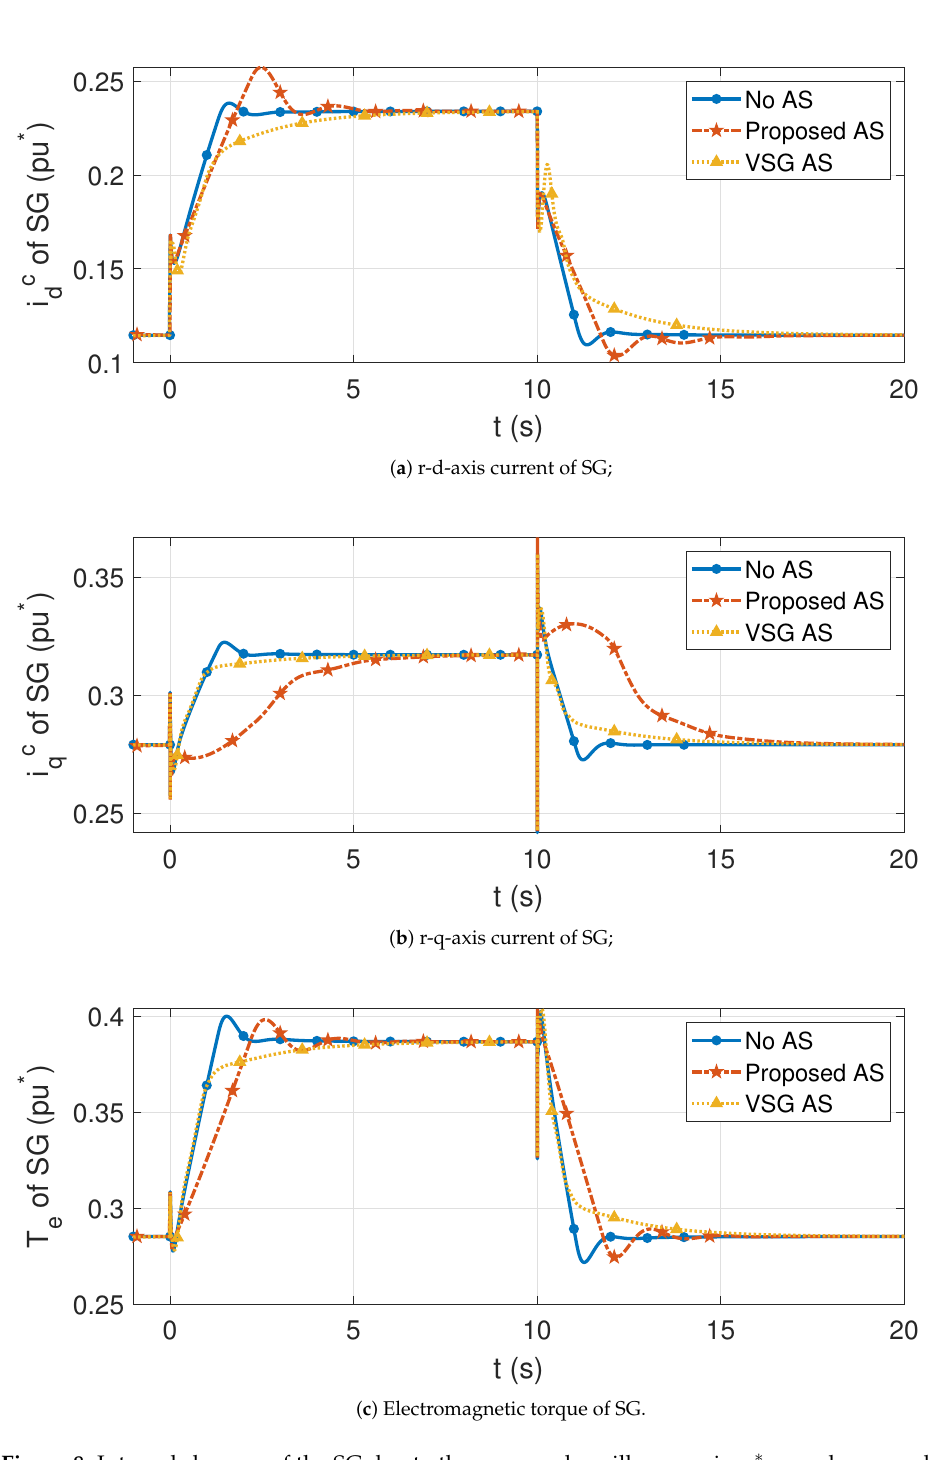
Figure 8. Internal changes of the SG due to the proposed ancillary service. ∗ pu values are obtained according to the base values of the synchronous generation system in Table